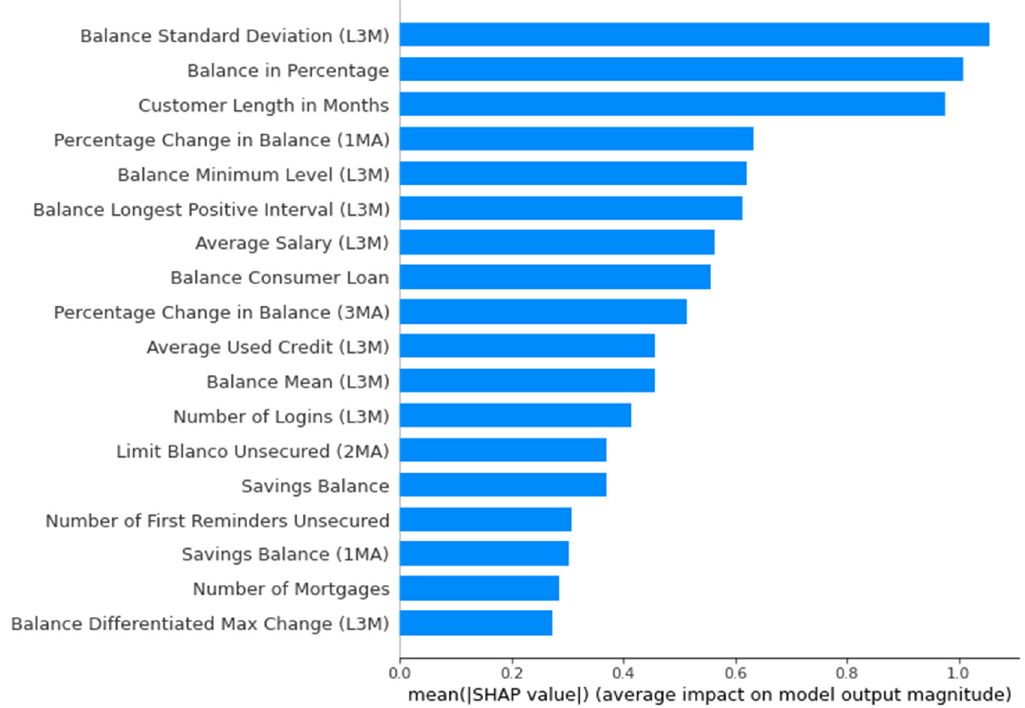
Figure 6. Simplified SHAP variable importance plot for the Light-GBM model, ranked by importance. Note that SHAP values are in absolute log-odds.